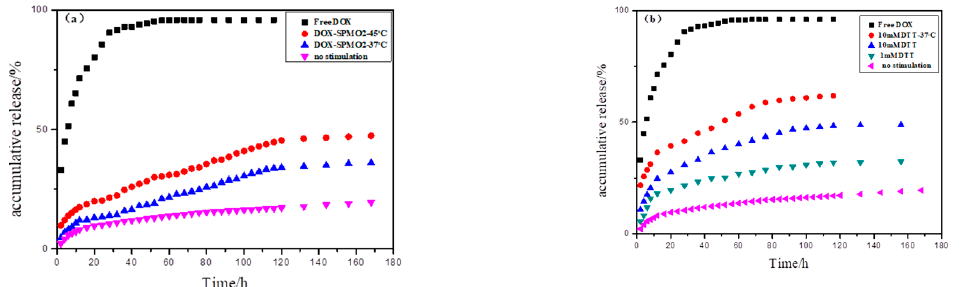
Figure 10. The drug release profiles of doxorubicin (DOX)-loaded micelles: ( a ) different temperatures stimulation and ( b ) different concentrations of DTT stimulation.